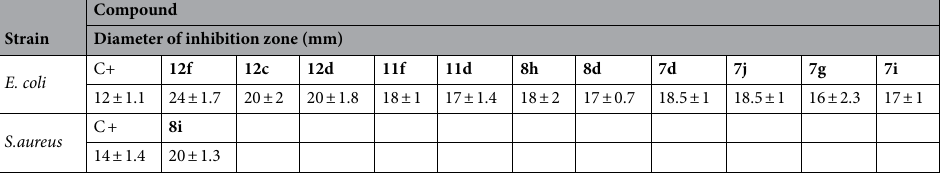
The in vitro five-dose assay screening results revealed that compound 11h possesses excellent anti-proliferative activity, with GI